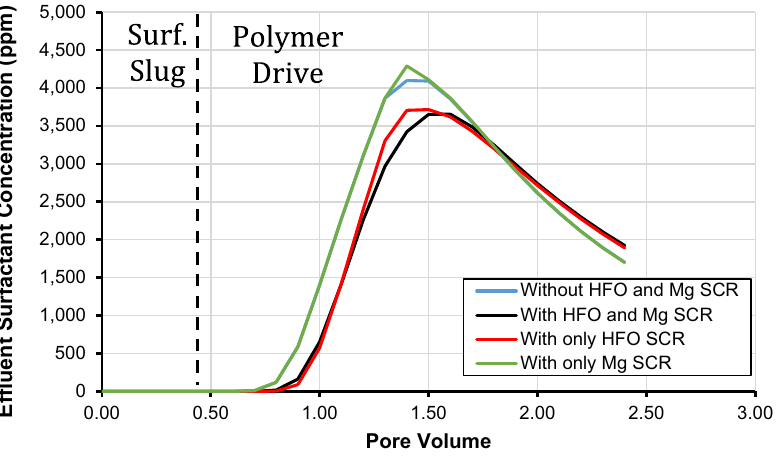
Figure 9. Effects of HFO and Mg surface complexation reactions on effluent surfactant concentration using the developed